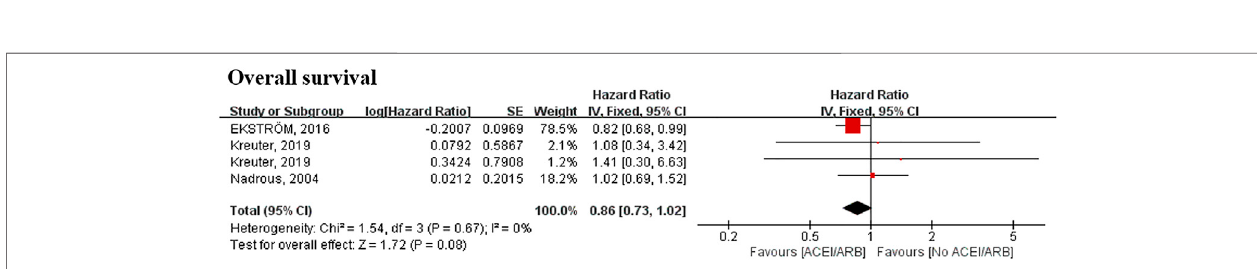
FIGURE 4 | Meta-analyses of the included studies examining overall survival for ACEI/ARB vs. no ACEI/ARB. The marker size indicates the relative weight of the study, as it contributes to the results of the overall comparison. IV indicates inverse-variance random-effects analysis; HR, hazard ratio; ACEI, angiotensin-converting enzyme inhibitor; ARB, angiotensin receptor